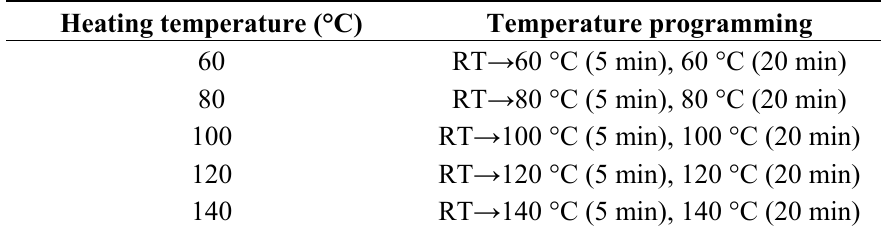
Table 1. Temperature programming of different set heating temperature.